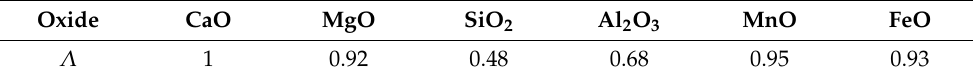
Table 5. Optical basicity of oxides.